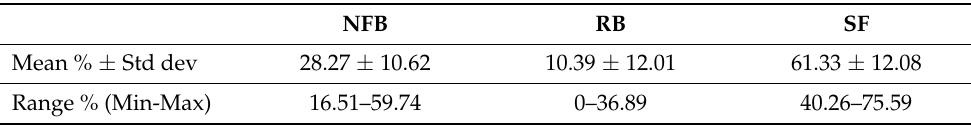
Table 2. Results of histomorphometric analysis from images of each biopsy core area taken at the time when the implant site was